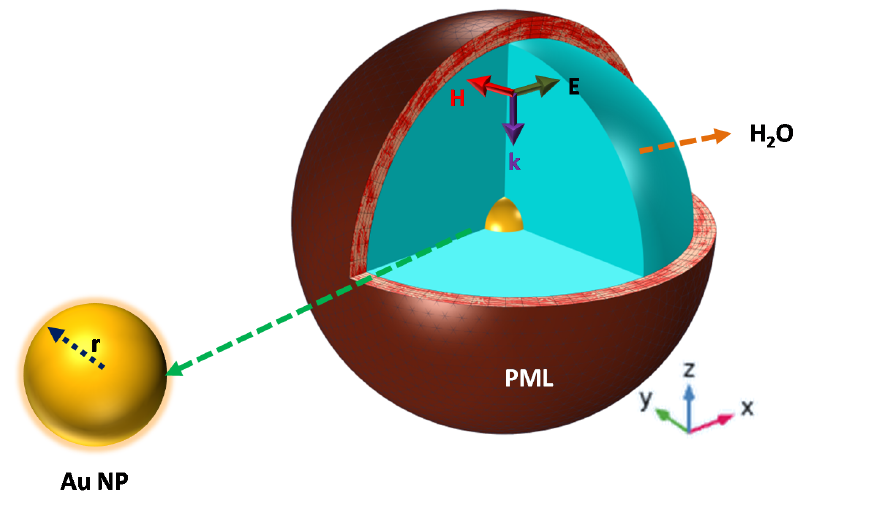
Figure 1. A 3D full-wave field analysis computational model with a PML domain and a spherical- shaped Au NP is immersed in surrounding medium